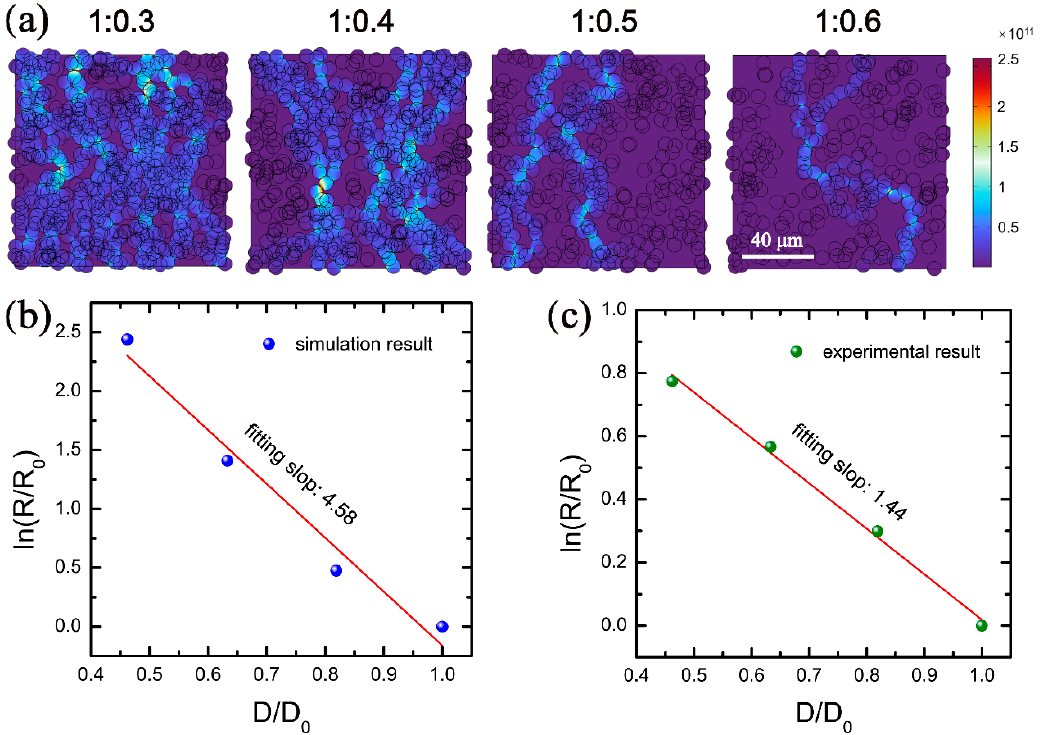
Figure 8. Comparison of simulation and experimental results. ( a ) The current density distribution inside the composite electrode under the mass ratios of Ag nanosheets to PDMS of 1:0.3, 1:0.4, 1:0.5, and 1:0.6, respectively. Contact point theoretical fitting of ( b ) simulation and ( c ) experimental results.